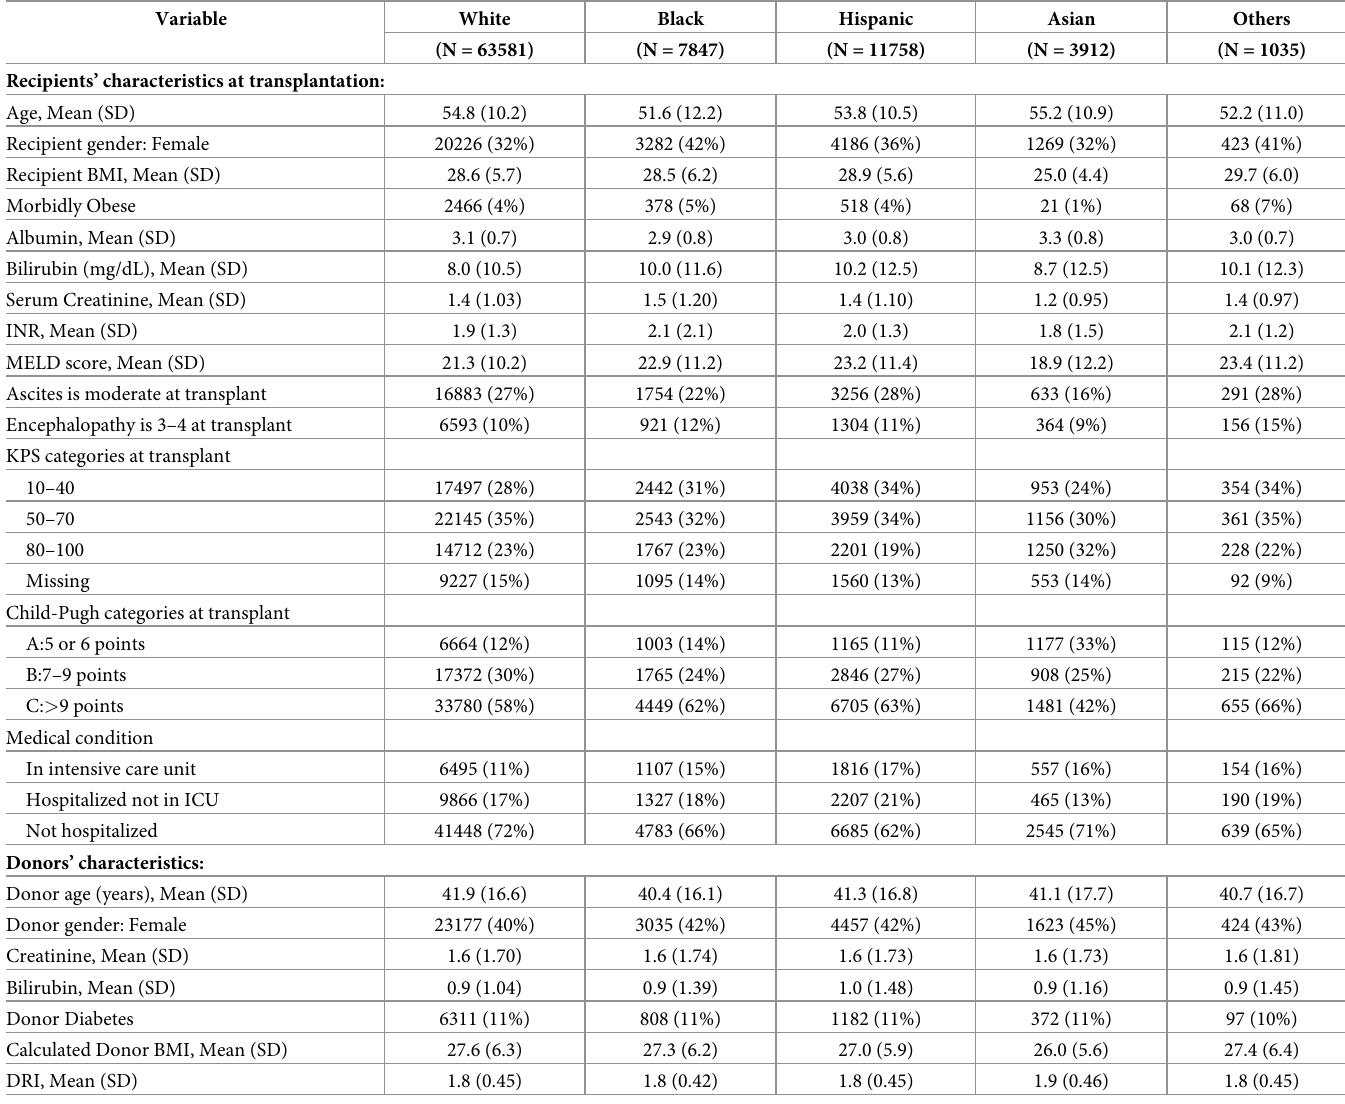
Table 3. Patient (at the time of transplant) and donor